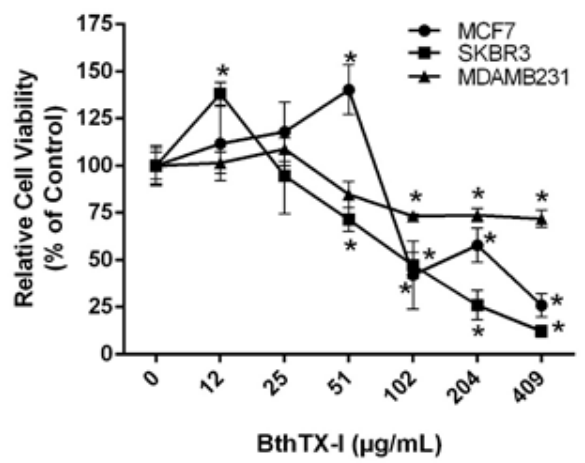
Figure 1. Viability of breast cancer cell lines treated with BthTX-I for 24h, assessed via MTT assay. Values represent the mean ± SD of at least three